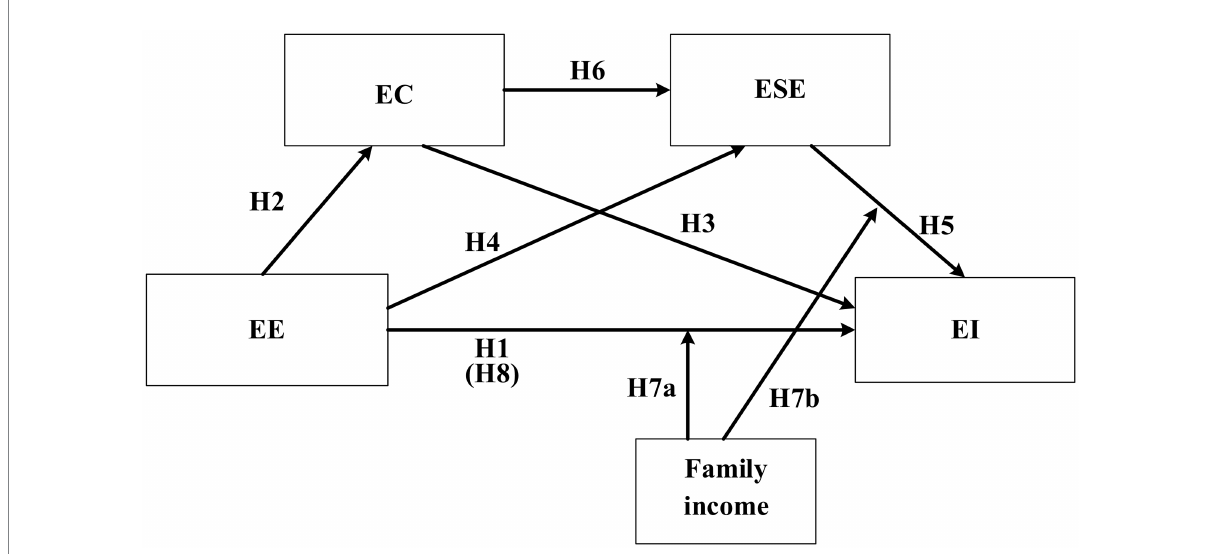
FIGURE 1 Hypothesised